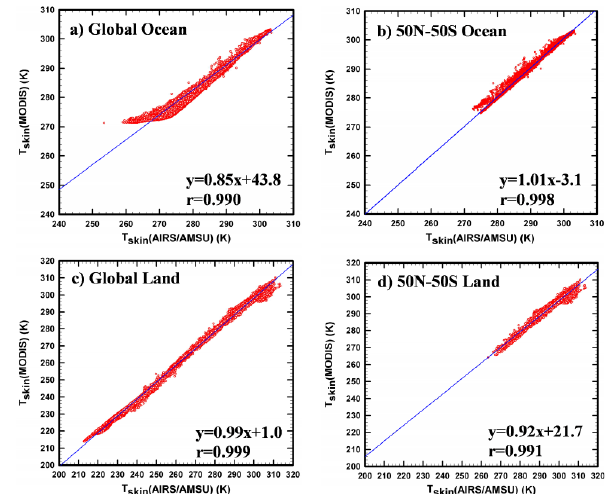
Fig. 3. Scatter diagrams in climatological annual average tempera- ture (K) of T skin (MODIS) versus T skin (AIRS/AMSU) during the period from September 2002 to August 2011 over the regions of (a) global ocean, (b) the 50 ◦ N–50 ◦ S ocean, (c) global land, and (d) the 50 ◦ N–50 ◦ S land. The values of AIRS/AMSU and MODIS have been compared with each other in a grid box of 1 ◦ × 1 ◦